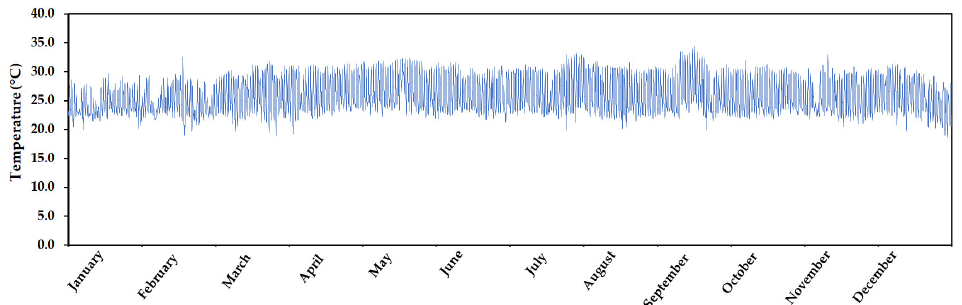
Figure 3. Hourly ambient temperature in Rogongon, Iligan